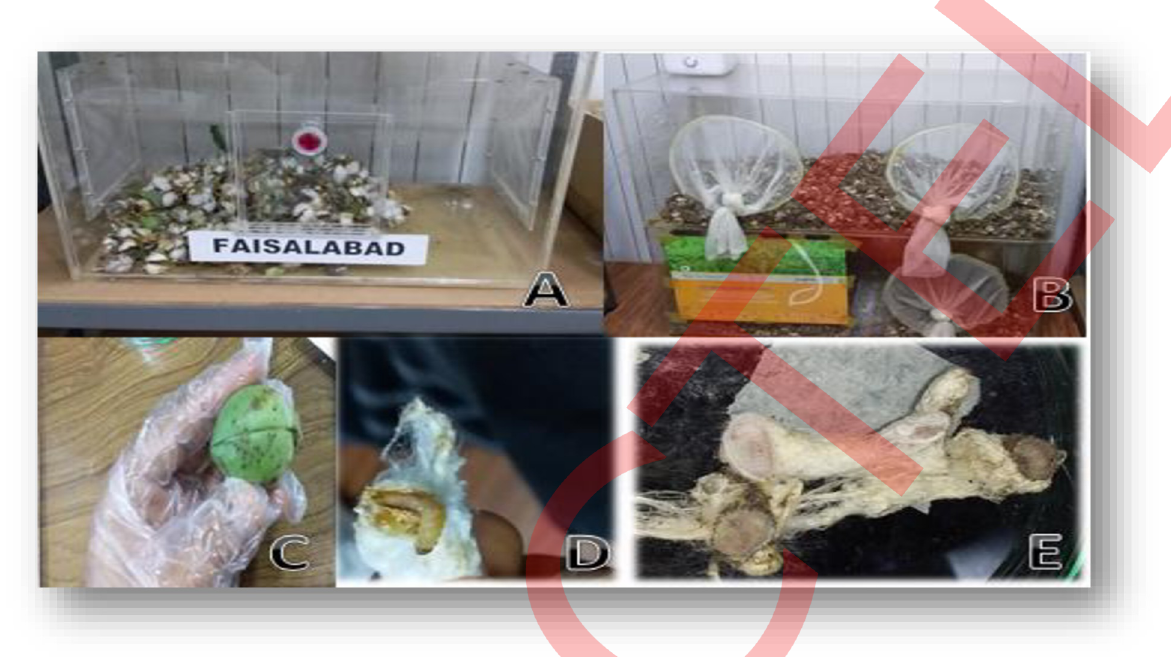
Fig 1. A-B: Pink bollworm moth collection cages. C: Infested cotton boll due to larval penetration of P . gossypiella . D: Larva feed inside the seed . E: Diapause larva under controlled laboratory condition.